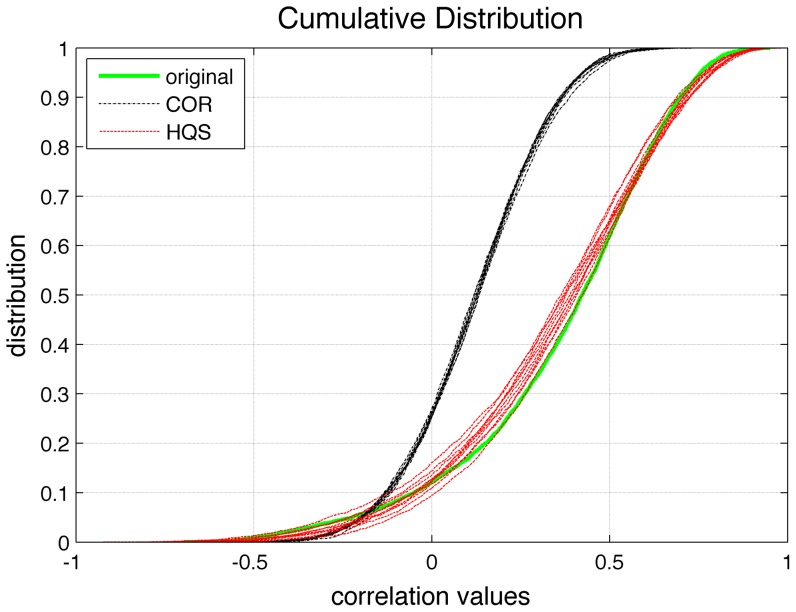
Cumulative distribution of correlation values.The correlation distribution of HC network (green), ten HQS null networks (red) and ten COR null networks (black). The cumulative distribution of correlation values in HQS model is very close to the original distribution while the distribution in COR model does not fit the original distribution. We did not show the correlation distribution for TOP model because the TOP model works on thresholded binarized networks.